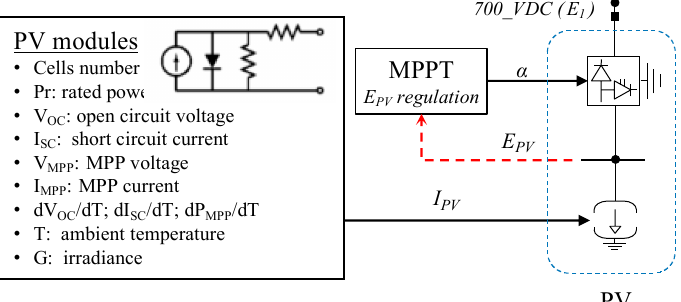
Figure 5. PV model developed in DIgSILENT PowerFactory to emulate the behavior of a PV generator depending on panel technical specifications and external conditions (weather, temperature, etc.).